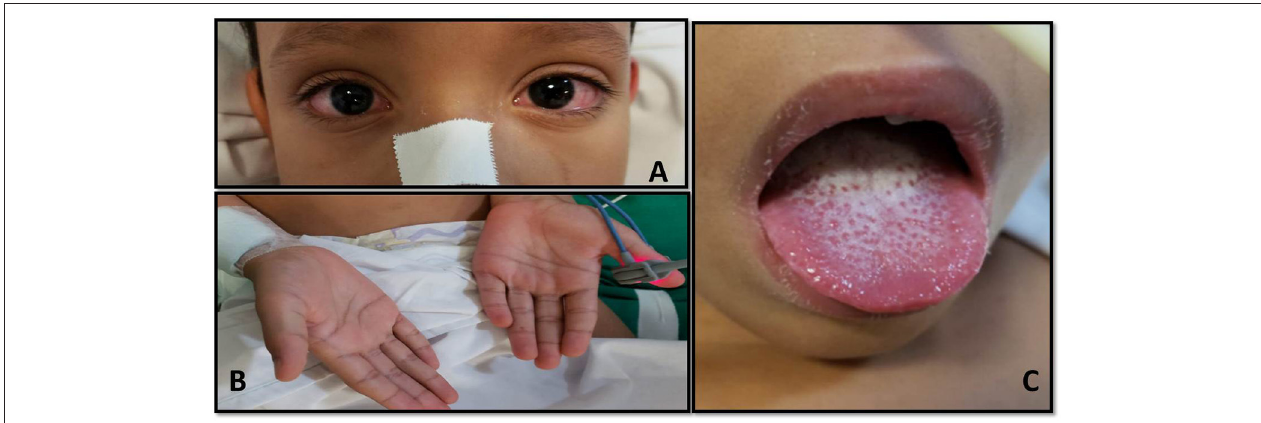
FIGURE 1 | (A) Presence of bilateral, nonexudative conjunctival hyperemia. (B) Maculopapular lesions in the palmoplantar region. (C) Presence of mucosal changes with peeling lip and raspberry tongue.